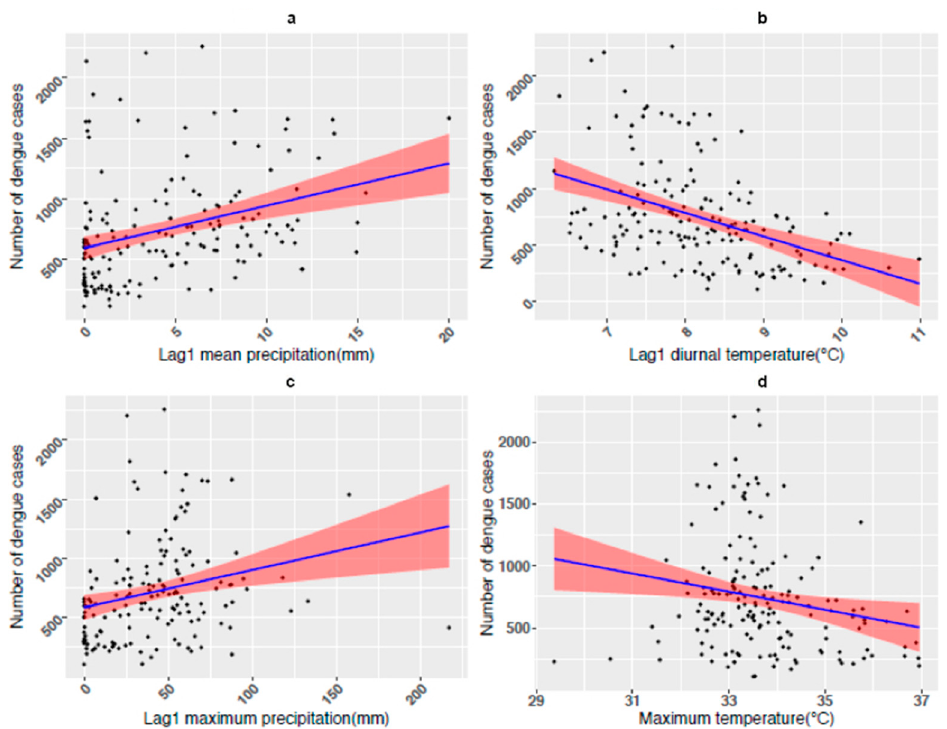
Figure A2. Relationship of significant meteorological variables with dengue incidence, 2000–2013, in